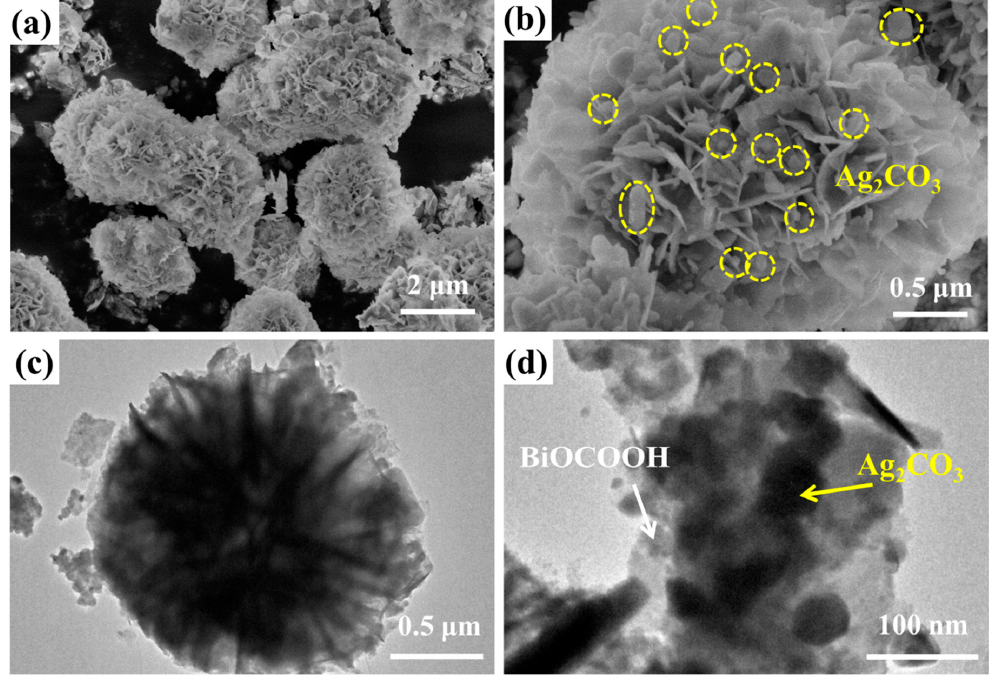
Figure 2. ( a , b ) SEM and ( c , d ) TEM images of ACO/BOCH-100.